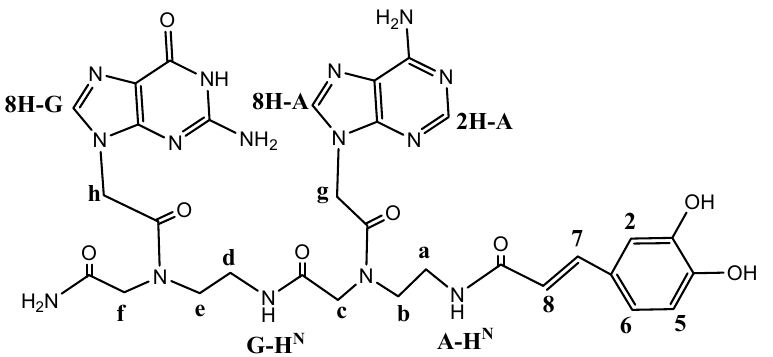
Figure 1. Atom numbering system used in NMR spectral analysis for dimer 1